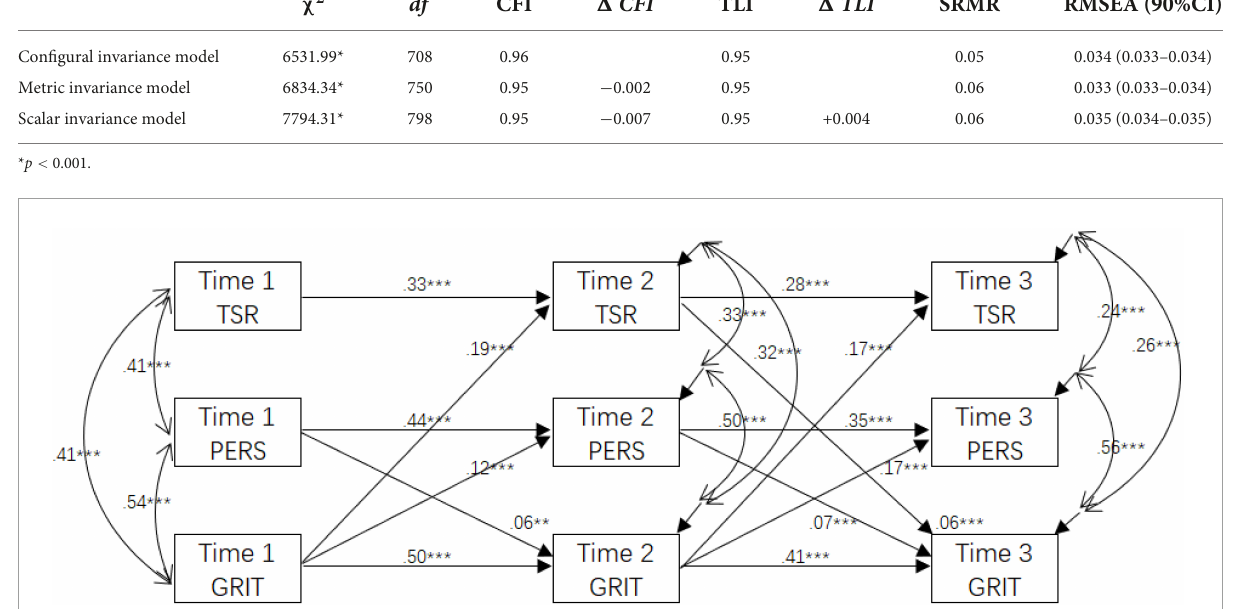
FIGURE1 Cross-lagged path analysis model on the relationships between social relationship and grit in the English as a foreign language (EFL) context. TSR, teacher-student relationship; PERS, peer relationship. ** p < 0.01, and *** p < 0.001.